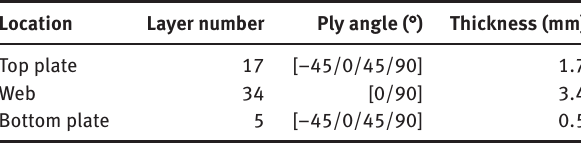
Table 3: Ply mode of different components in the box girder. Location